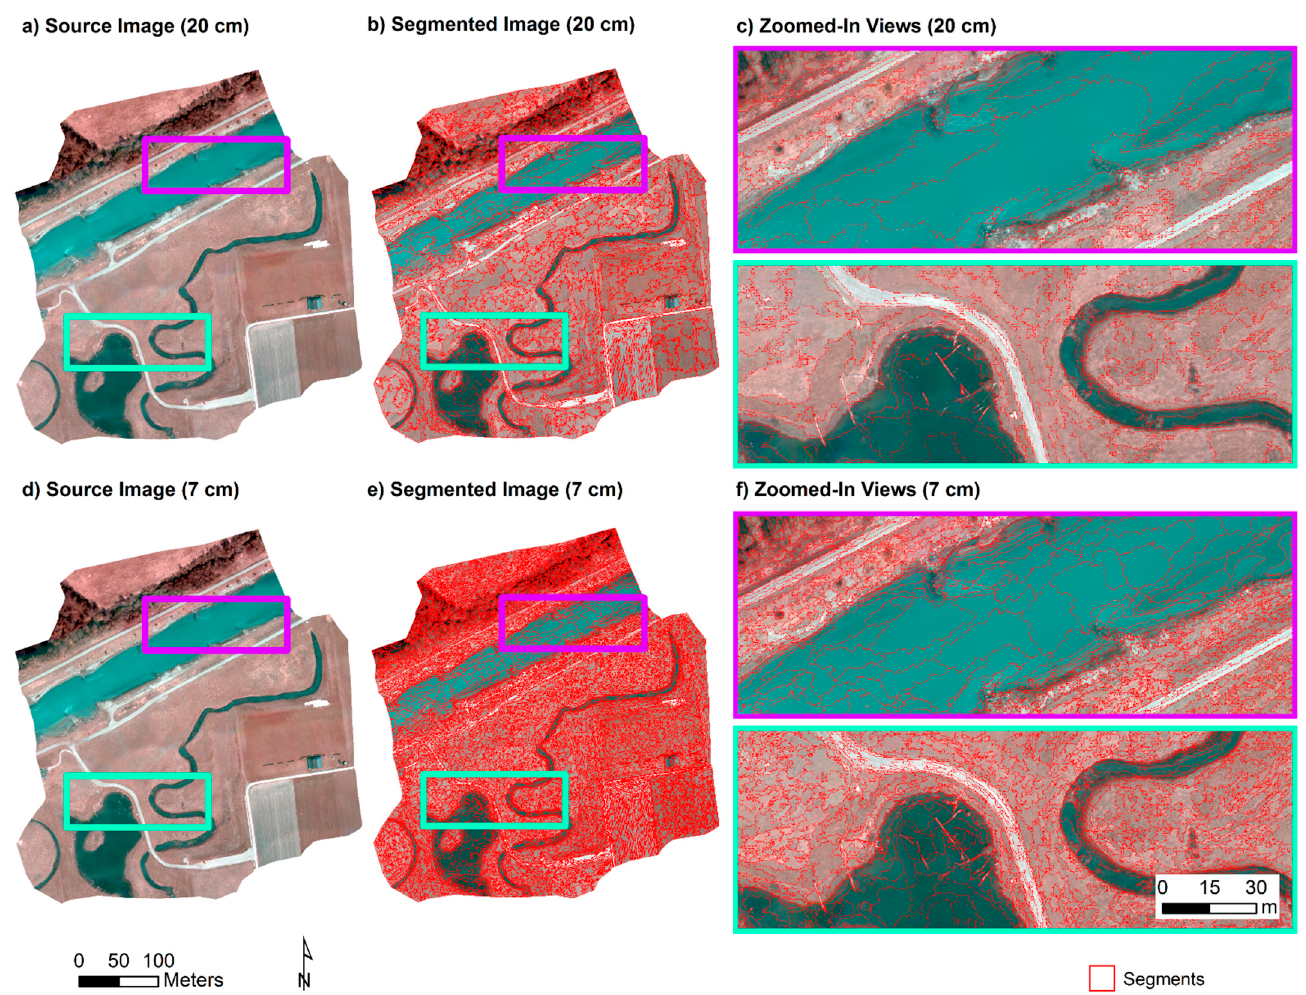
Figure 3. ( a ) Narrow-band image from 11 April 2016 of the River Gail study area with 20 cm pixel size (bands 772, 667, and 550 nm as R,G,B); ( b ) Image segments generated using eCognition ® for the 20 cm narrow-band image; ( c ) Zoomed-in views to the source image and segments depicted by the purple and cyan rectangles in ( a ) and ( b ); ( d ) Narrow-band image from 11 April 2016 of the River Gail study area with 7 cm pixel size; ( e ) Image segments generated using eCognition ® for the 7 cm narrow-band image; ( f ) Zoomed-in views to the source image and segments depicted by the purple and cyan rectangles in ( d ) and ( e ).